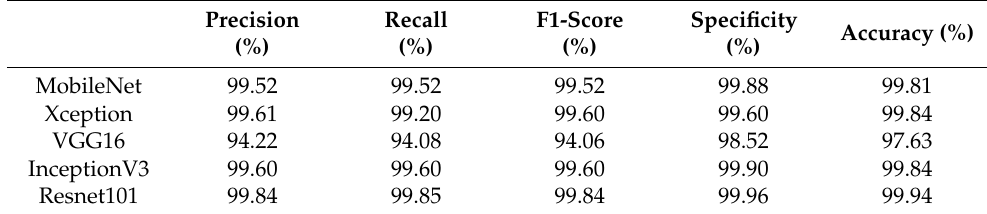
Table 4. Average classification results for the classification task.